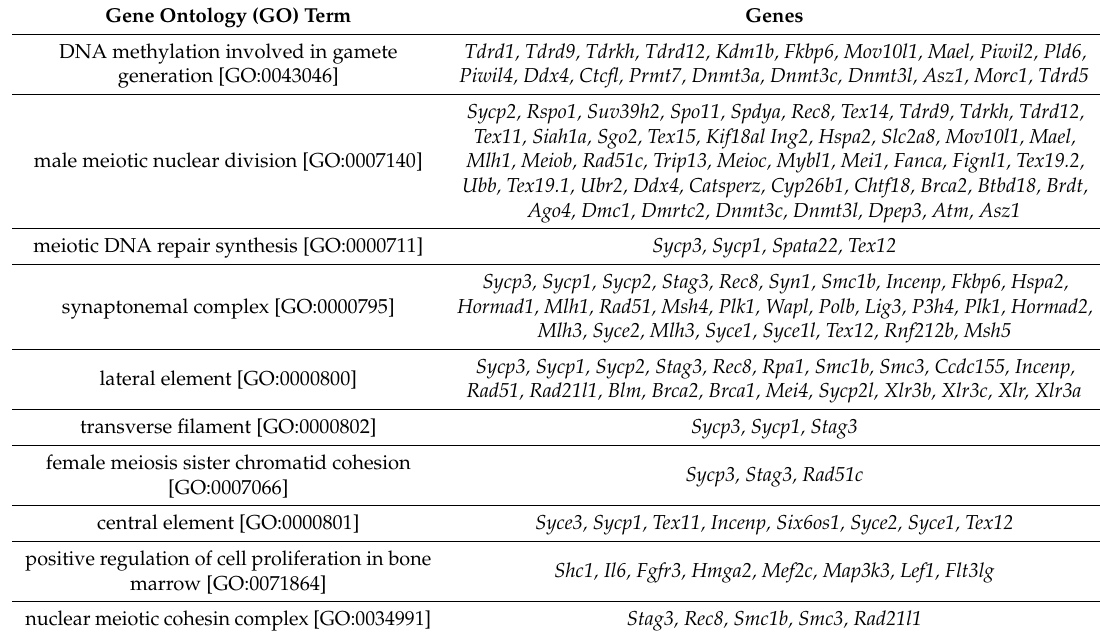
Table 5. Significant gene ontology terms at all age